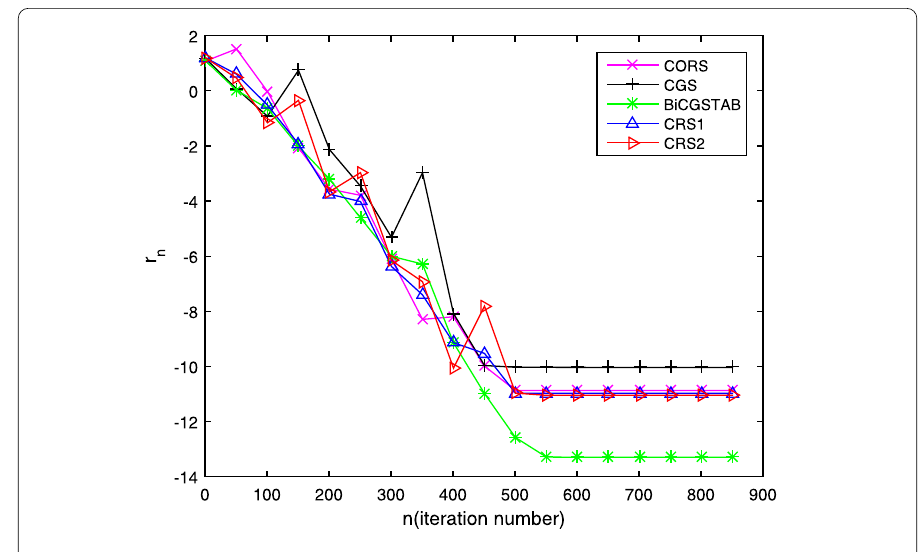
Figure 1 The residual for Example